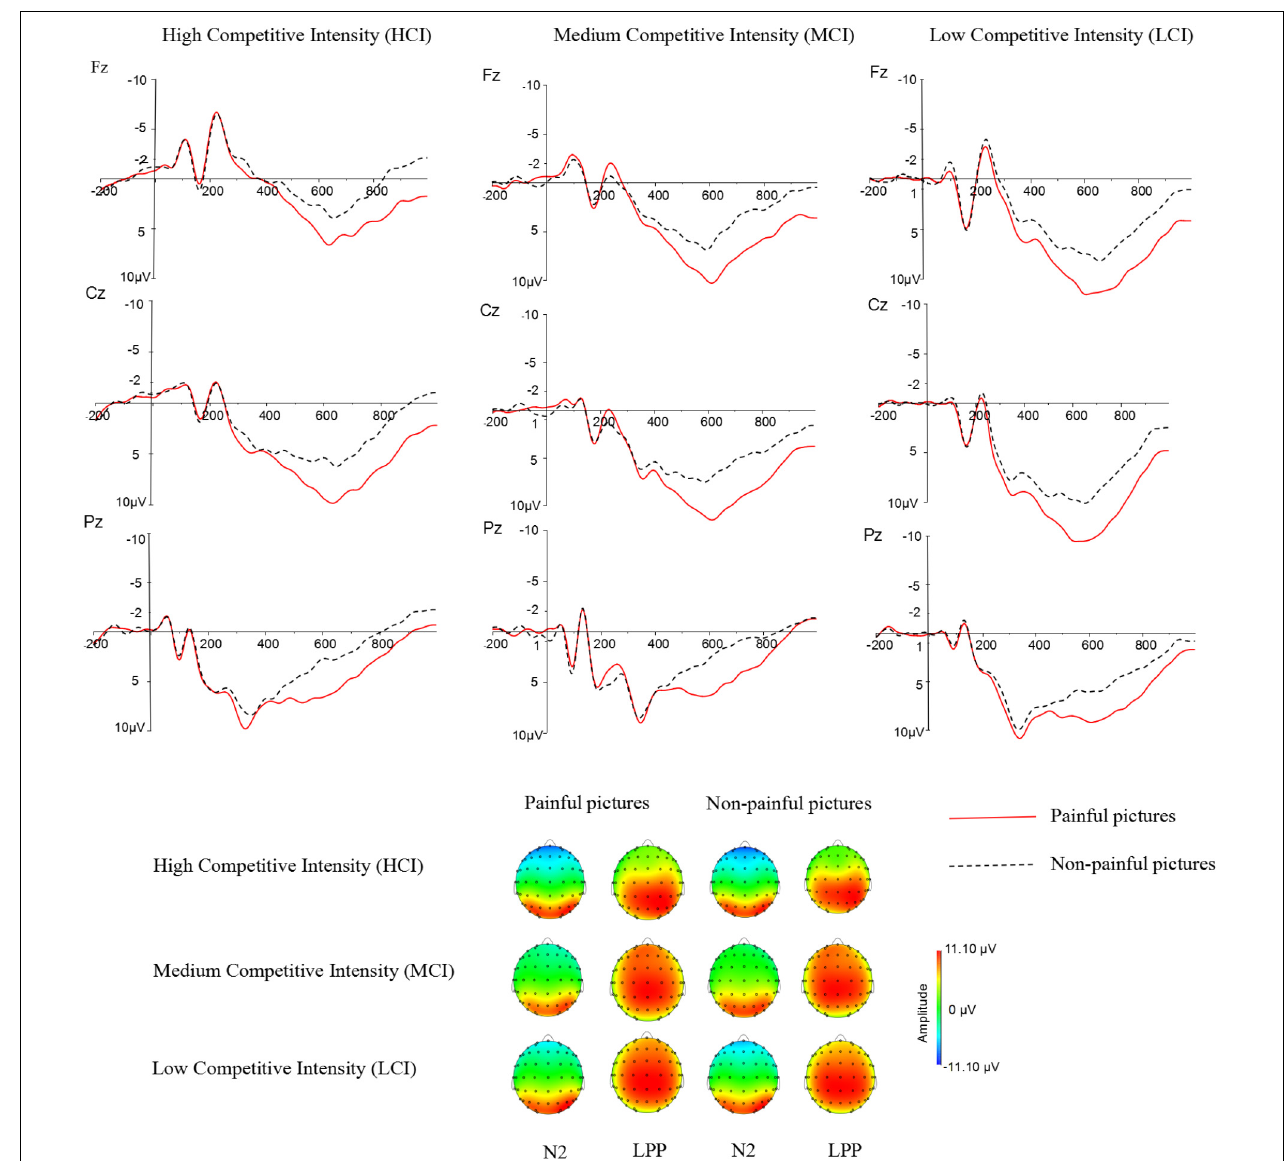
FIGURE 2 | Average ERPs at Fz, Cz, and Pz for pain pictures and non-pain pictures under high competitive intensity (HCI), medium competitive intensity (MCI), and low competitive intensity (LCI) conditions, and the topographical map during 220–250 ms time windows (N2) and 350–600 ms time windows